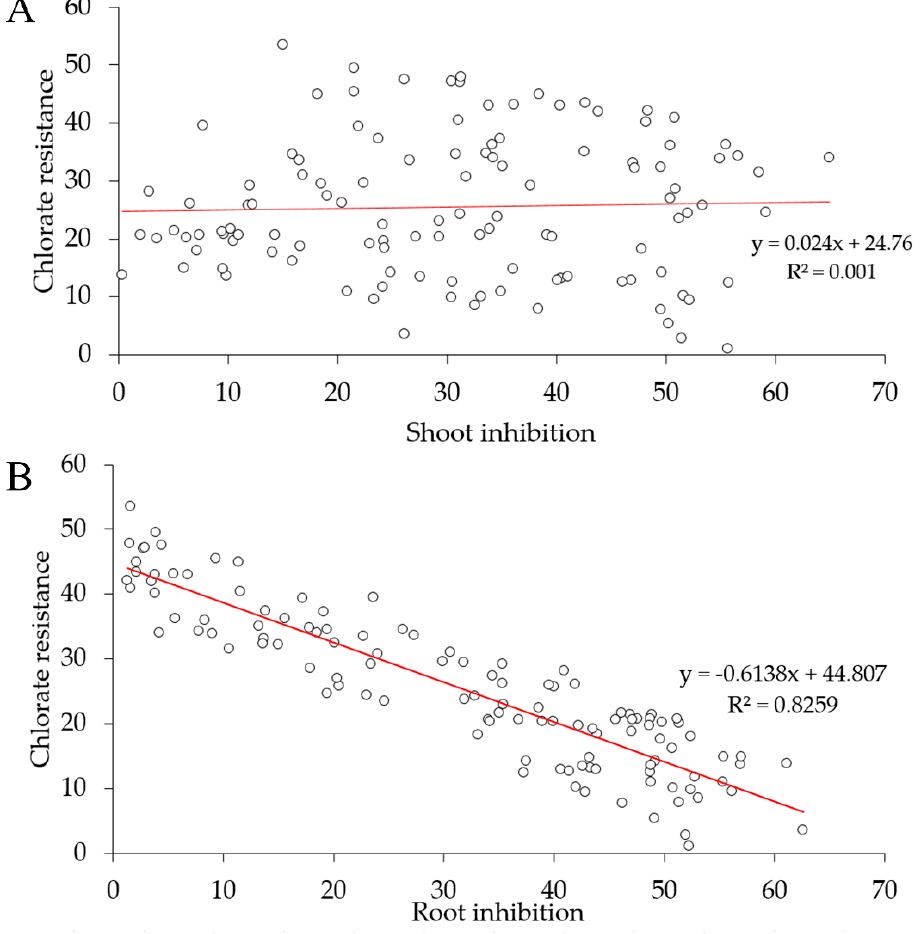
Figure 2. Correlation between seedling growth inhibition and chlorate resistance. ( A ) Predicted correlation (weak positive) between shoot inhibition percentage and chlorate resistance score and ( B ) predicted negative correlation between root inhibition and chlorate resistance phenotypes.